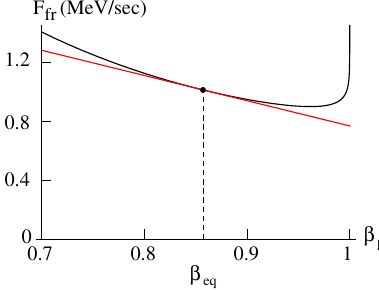
FIG. 13. The average ionization losses (black curve) and its linear approximation (red line) as a function of muon